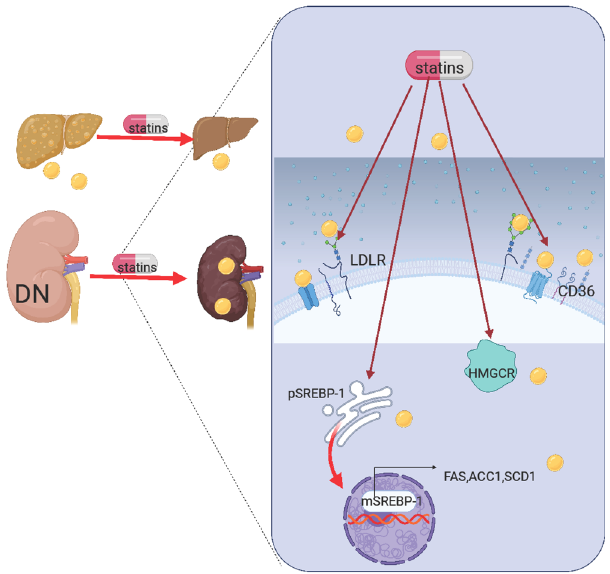
Fig. 10 | Graphical representation of long-term statins administration exacer- bates diabetic nephropathy via EFD. Long-term administration of statins acti- vates SREBP-1 fatty acid synthesis signaling, increases kidney lipid uptake, and inhibits fatty acid oxidation, which leads to EFD in the kidneys of diabetic mice. Graphics were created with